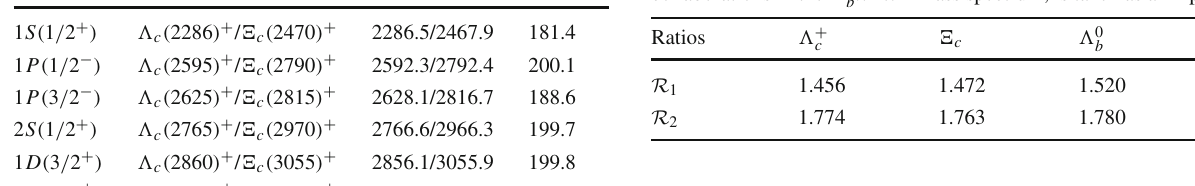
Table 2 The extracted ratios of R 1 and R 2 (see Eq. (1)) for the (cid:9) Q and (cid:3) Q baryons. The 2 S candidate of (cid:9) b baryon with the mass around 6.07 GeV, which was found recently by the CMS [62] and LHCb [50]